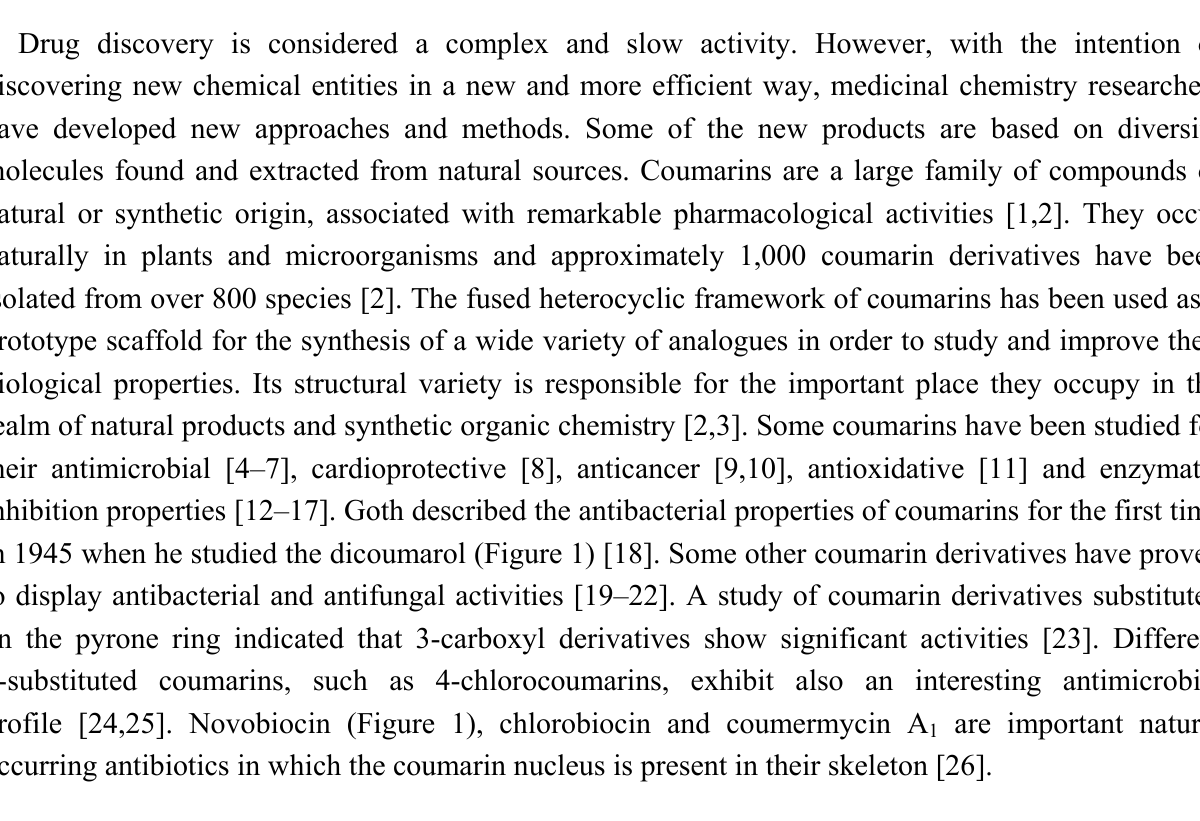
Figure 1. Chemical structures of dicoumarol and